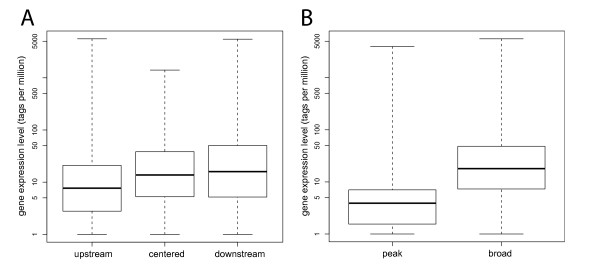
Comparison of the gene expression level of the three clusters, and of peak vs. broad promoters. Gene expression level (A) in the three clusters and (B) in the single peak and broad groups of the clustered promoters. The y-axis shows the gene expression level (GEL) in units of tags per million (tpm) in log-scale for visibility reasons, a pseudo count of 1 tpm was added to each promoter to avoid logarithm of zero. The comparisons of GEL are highly significant for both tests, between the three clusters (Kruskal-Wallis test, p-value = 1.05E-10) as well as between the single peak and broad class (Wilcoxon rank-sum test, p-value = 5.5E-15).